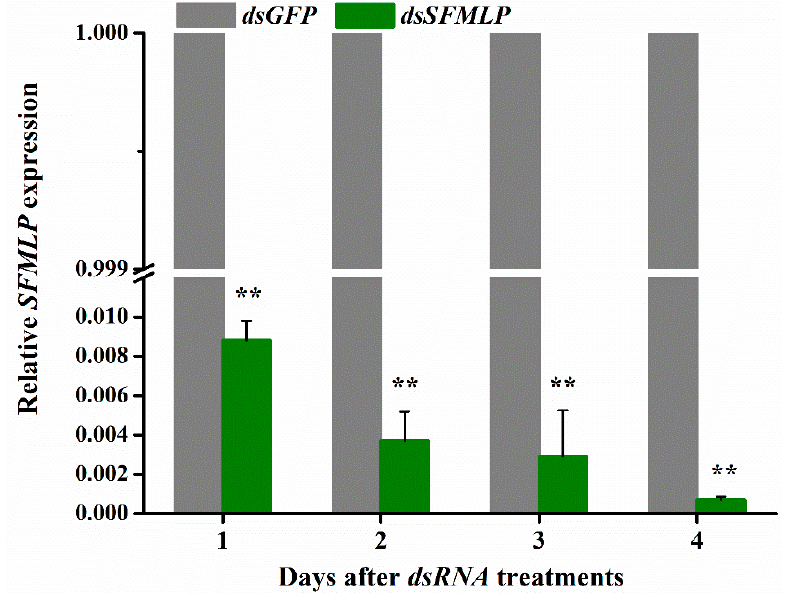
Figure 1. Relative expression level of SFMLP in WBPH after injection of dsRNA. ds GFP indicates WBPH injected with GFP - dsRNA ; dsSFMLP indicates WBPH injected with SFMLP - dsRNA . The mRNA expression level in the dsGFP group is designated as 1.0. ** indicates statistically significant differences ( t- test: p < 0.01). Bars, ±SEM.